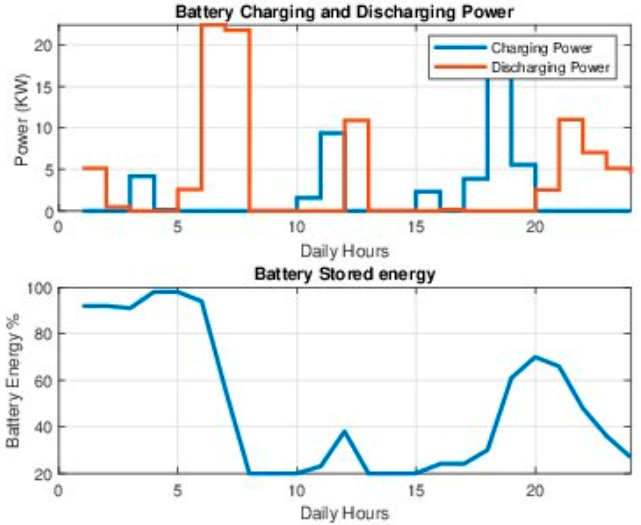
Figure 26. Graph of charging and discharging of battery during 24 h of a day.